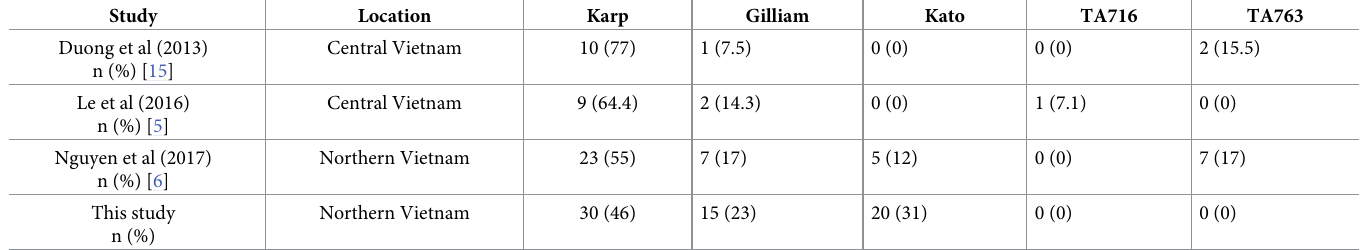
Table 2. Prevalence of current circulating genotypes of O . tsutsugamushi in